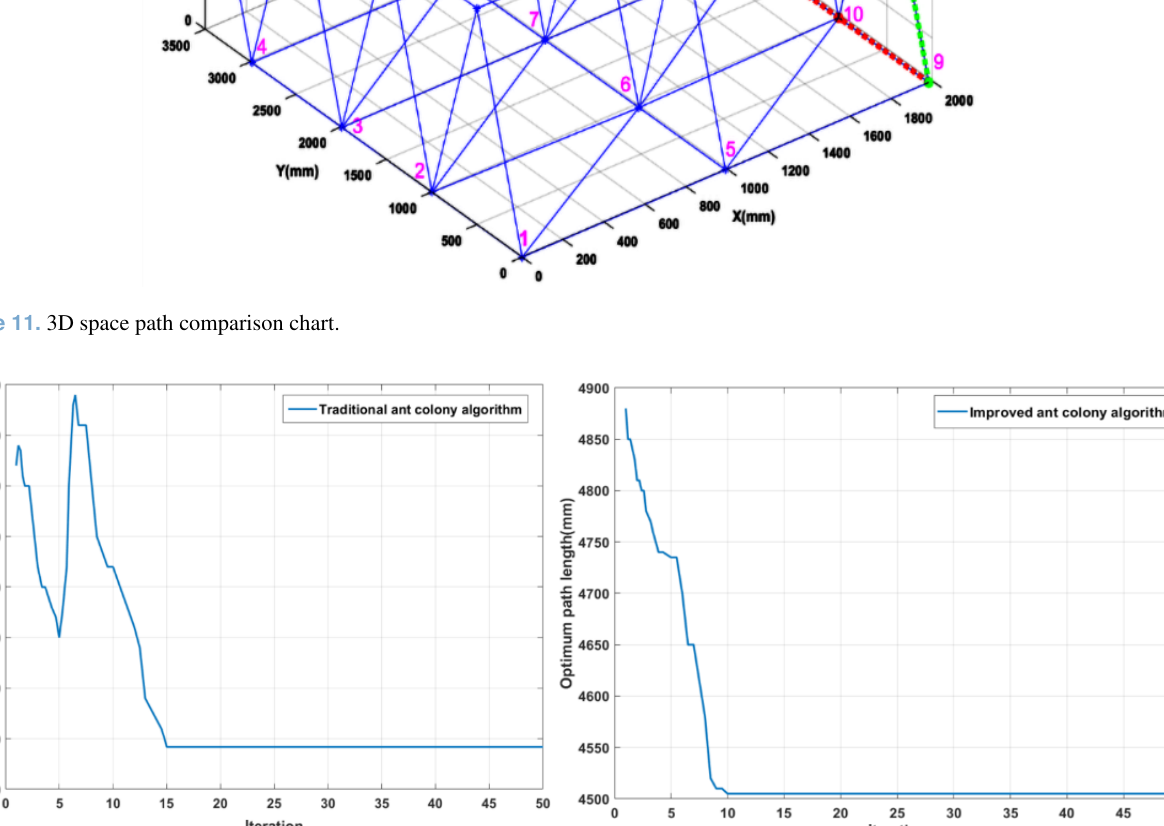
average path length is 4795.000 mm, the adjustment time is 11.235 s, the planning time is 13.381 s, and the operation ef- ficiency is 83.9 %. For the first time, the number of shortest path iterations is 15, the number of convergence iterations of all ants is 30, and the percentage of effective iterations is 50